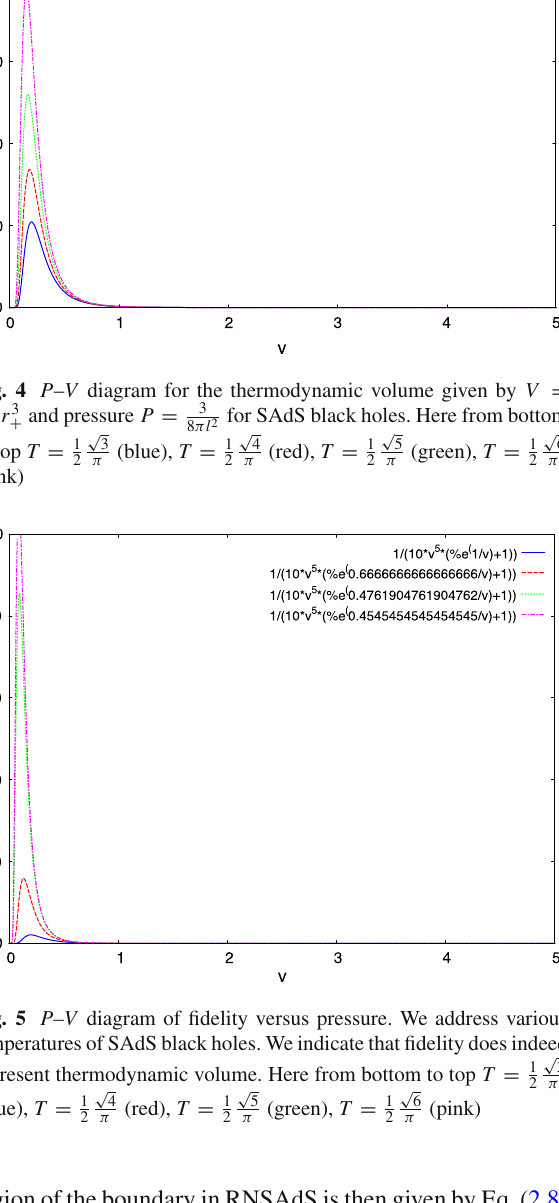
√ √ 4 = 1 5 π (red), T π (green), T 2 2